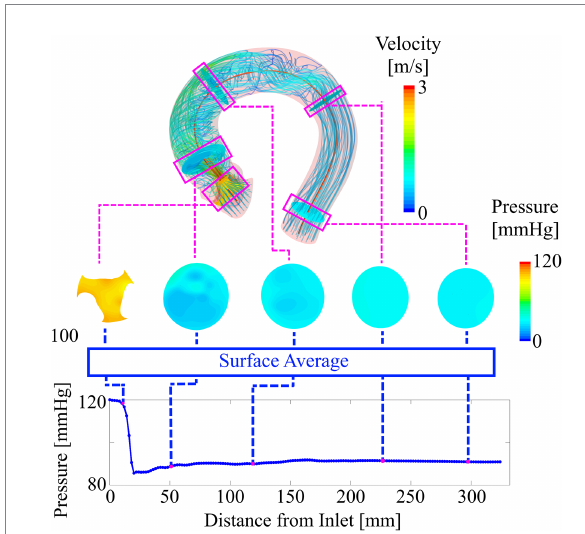
FIGURE 4 Deriving the compact representation (bottom plot) from the three- dimensional pressure and velocity field (top). Cross-section planes are defined along the vessel centerline. The average values of pressure on these planes are used to plot locally averaged pressure along the vessel centerline. Similarly, average values of WSS are computed from vessel sections between two adjacent cross- sections. FIGURE 5 Schematic depiction of the artificial neural network (ANN) based